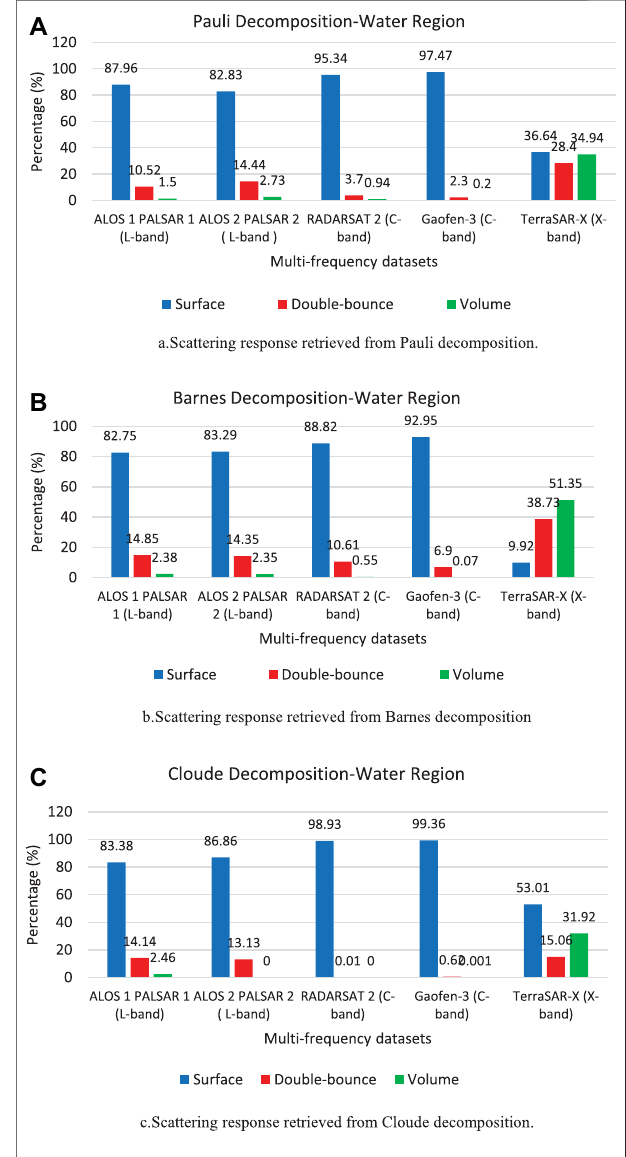
FIGURE 9 | Backscattering response for water region obtained from Pauli, Barnes, and Cloude decomposition models.